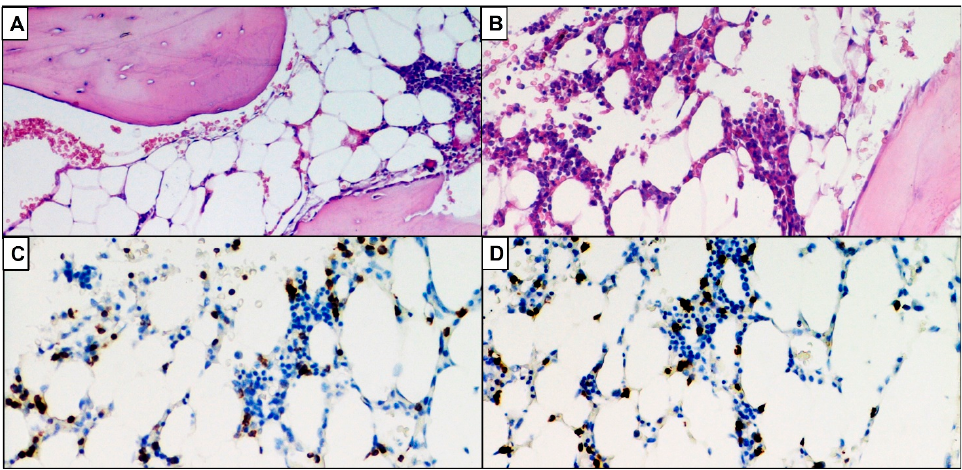
Figure 3. Remarkably hypocellular bone marrow. ( A , B ) Hematoxylin-eosin, original magnification 100 × . ( C ) Immunoreactivity for CD3, immunohistochemistry, 100 × . ( D ). Immunoreactivity for CD8, immunohistochemistry, 100 × .